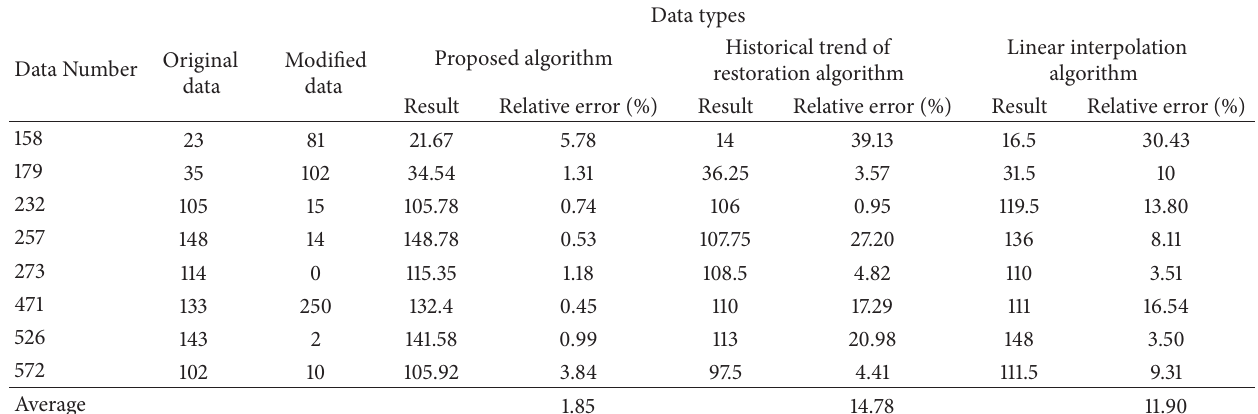
Table 3: Comparation of the three methods.